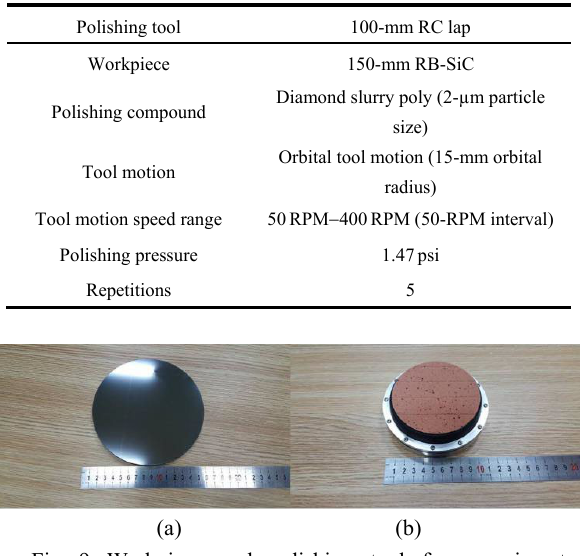
Table 2 Overall experimental conditions.